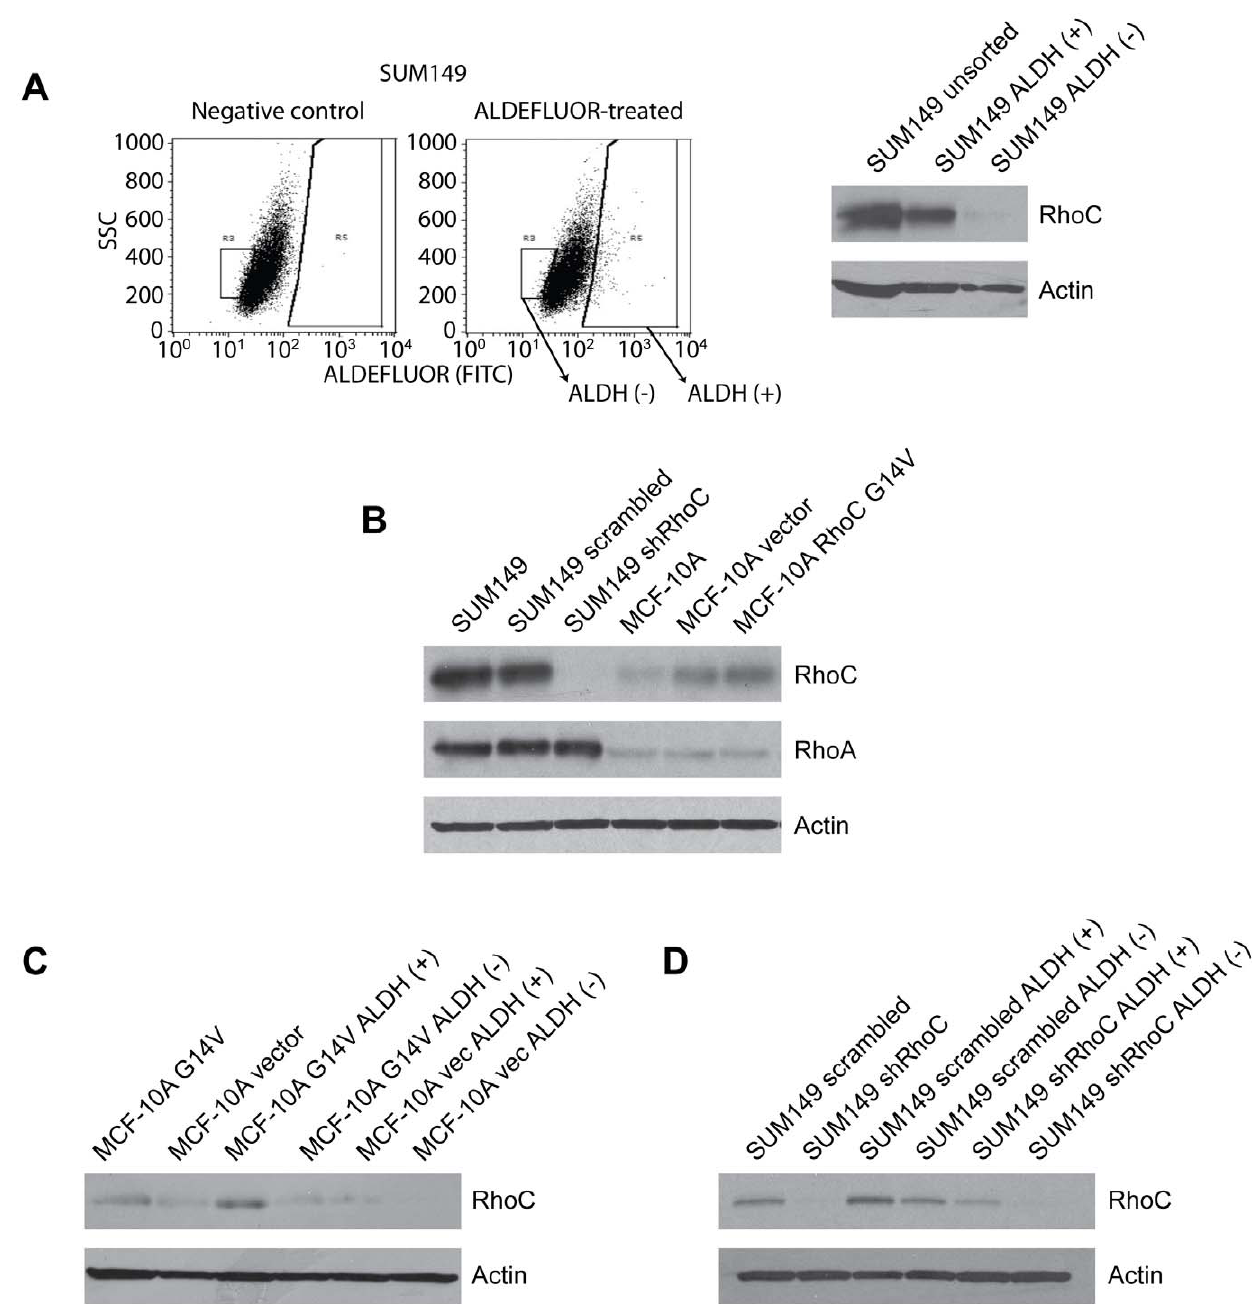
Figure 1. RhoC expression is intimately linked to the ALDH ( + ) breast cancer stem cell population in SUM149 and MCF-10A G14V cells. ( A ) (left) ALDH ( + ) and ( 2 ) cells were isolated by FACS of ALDEFLUOR-treated SUM149 cells. (right) RhoC expression is linked to BCSC status in SUM149 IBC cells. ( B ) Generation of RhoC knockdown SUM149 cells and constitutively active RhoC (RhoC G14V)-overexpressing MCF-10A cells. Importantly, modulating RhoC expression did not affect expression of the close homolog RhoA. ( C–D ) Interestingly, even when RhoC is exogenously expressed or inhibited in MCF-10A ( C ) or SUM149 cells ( D ), RhoC expression still segregates to the ALDH ( + ) population.